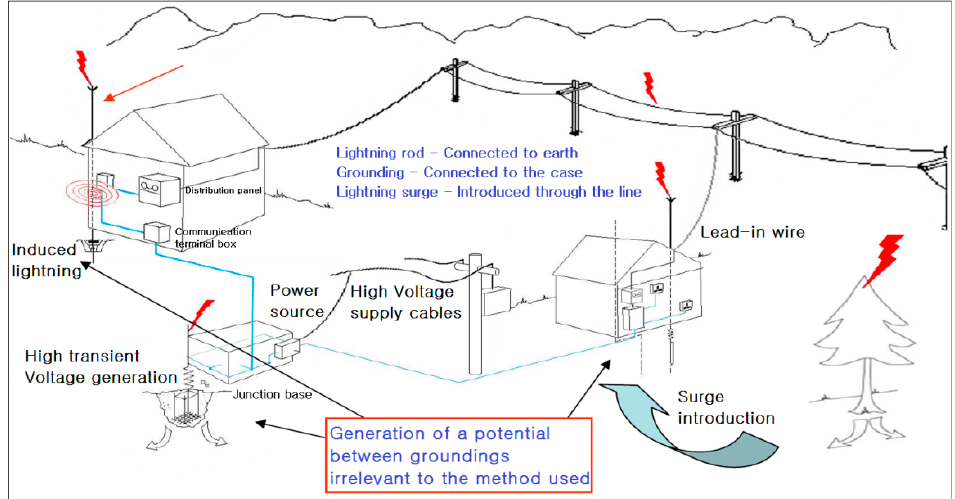
Figure 4. Path of lightning and cause of damage.